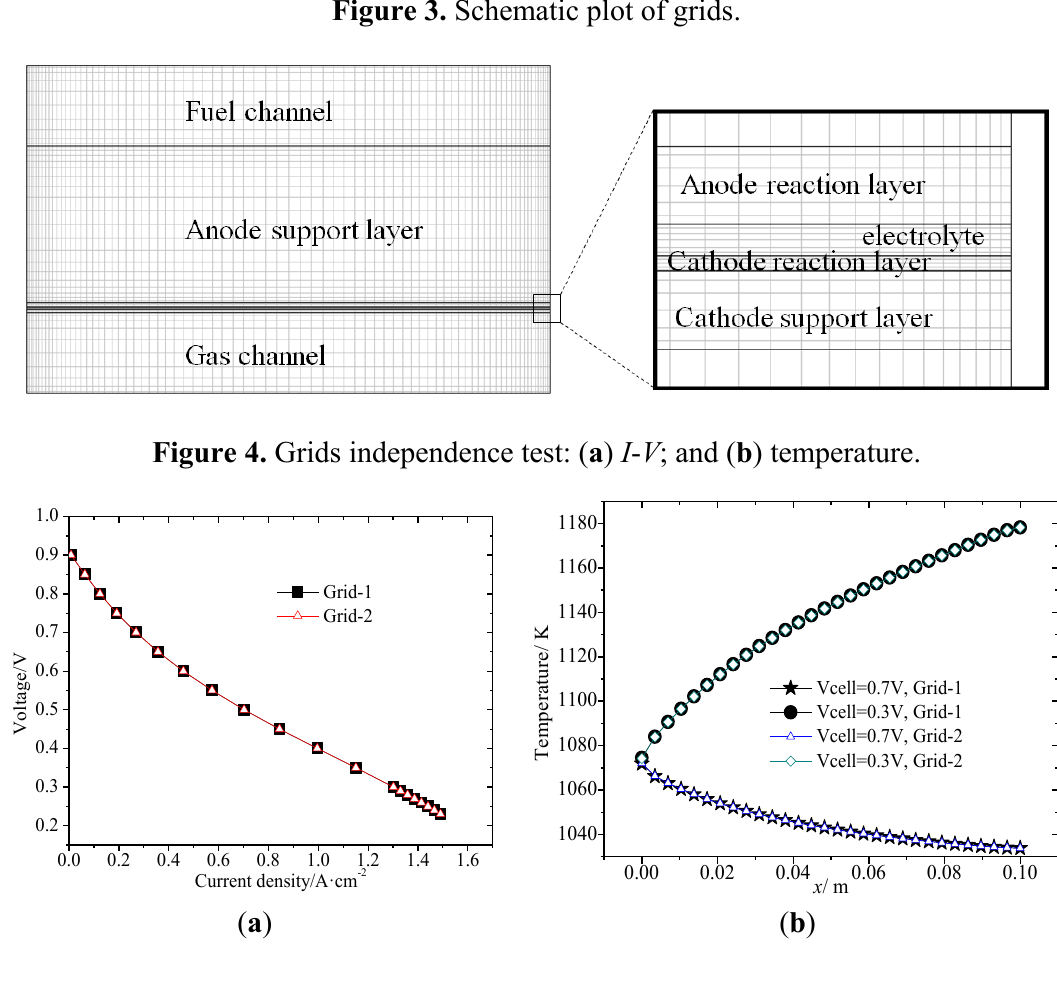
Figure 3. Schematic plot of grids.